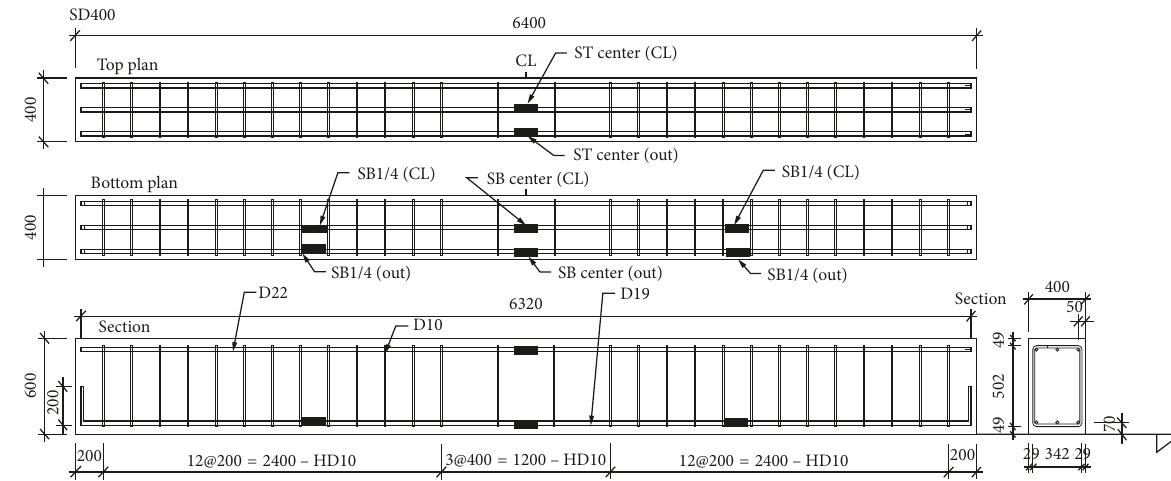
Figure 10: Layout of rebar gauges (in mm).